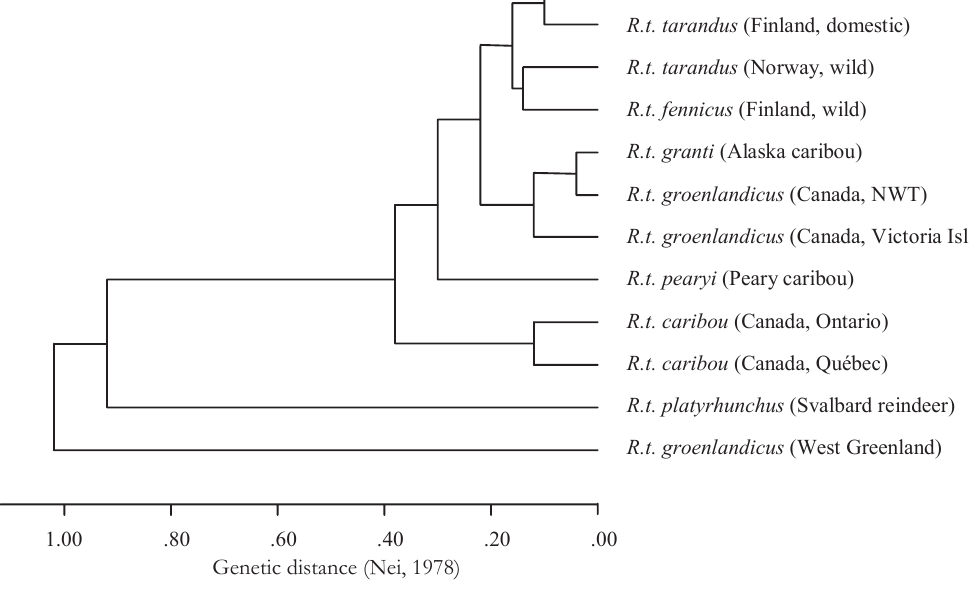
loci.Genetic distance (Nei, Fig. 3. Cluster analysis of the genetic distance (Nei, 1978) between subspecies of reindeer and caribou based on variability in 13 microsatellite